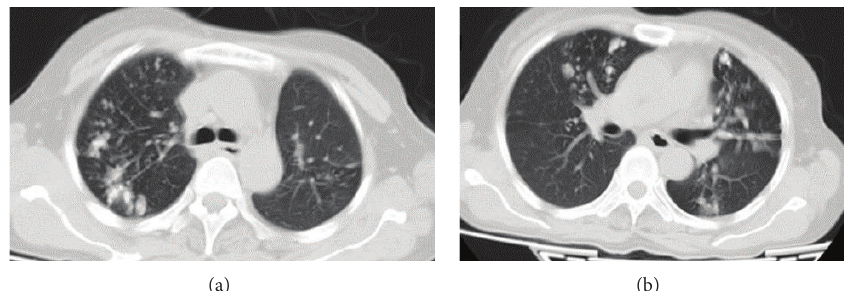
Figure 3: Multiple irregular opacities in apical segments of right upper lobe and left lingular superior segment, anterobasal and posterobasal segments suggestive of